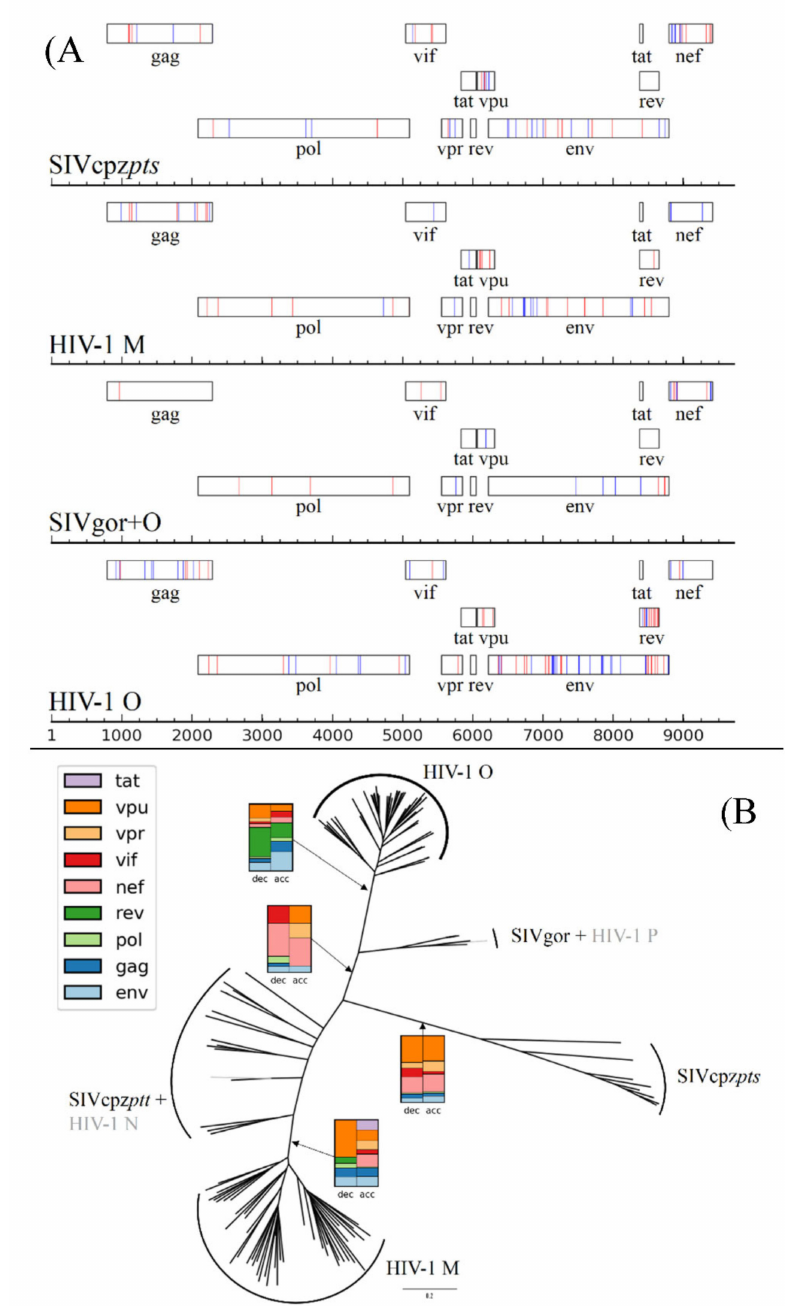
Figure 2. ( A ) Proposed rate deceleration (red) and acceleration (blue) events in prominent branches shown along the genome using the coordinates of the HXB2 reference strain. ( B ) Proposed rate-shift patterns in prominent branches, shown on the phylogeny. Rate shifts (deceleration left and acceleration right) are shown as the percentage of total rate-shift events at each branch, while controlling for protein